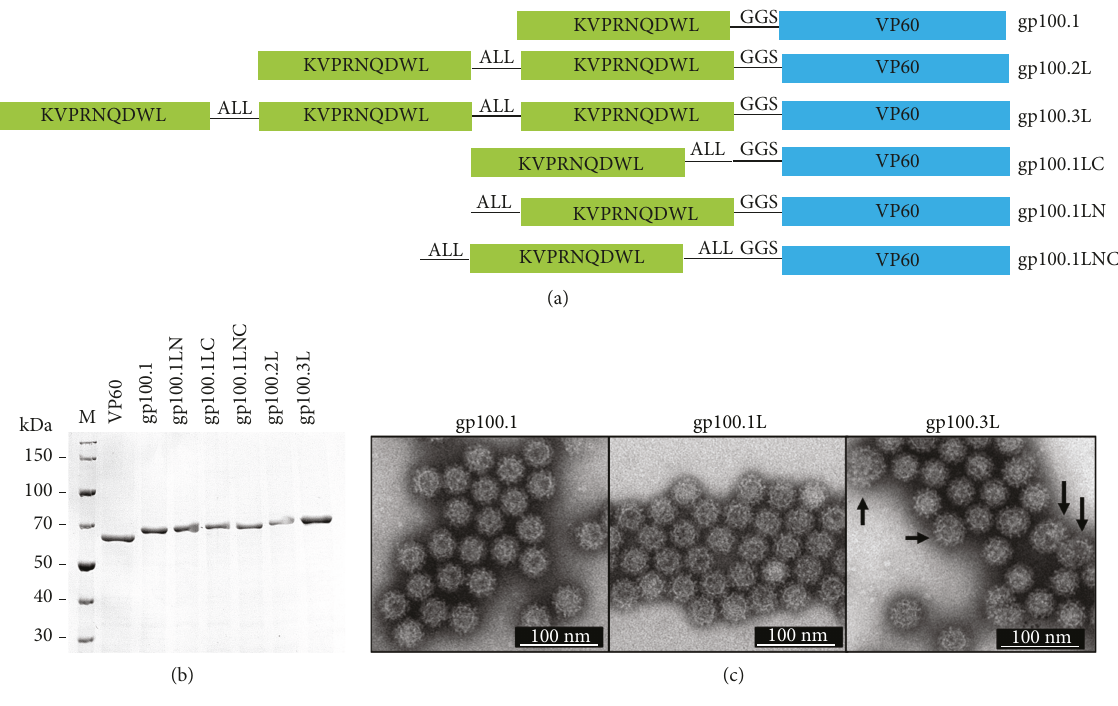
Figure 1: gp100 RHDV VLP design and expression. Each gp100 RHDV VLP was expressed in Sf21 cells and puri fi ed for analysis and applications in vaccination. (a) Diagram outlining the structure and linker position for each gp100 VLP. (b) SDS-PAGE for RHDV VLP with one (gp100.1, 1LN, 1LC and 1LNC), two (gp100.2L), and three (gp100.3L) gp100 epitopes compared to unmodi fi ed VP60. (c) Electron microscopy to con fi rm particle formation for gp100.1, 2L, and